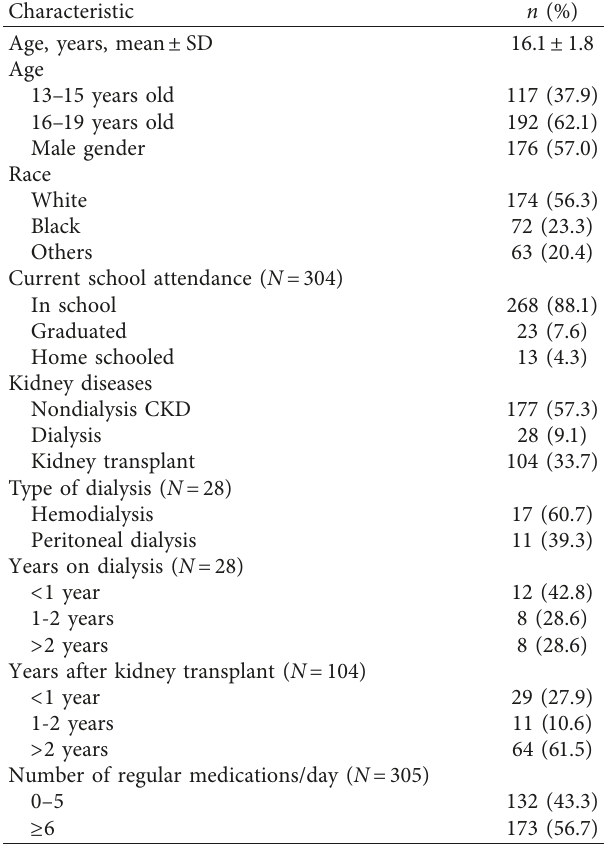
Table 1: Characteristics of adolescents with